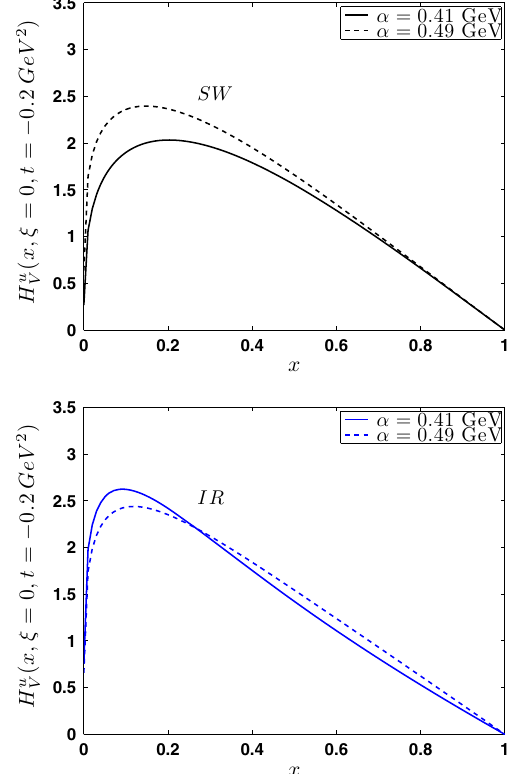
( x ,ξ = 0 , t = − 0 . 2GeV 2 ) V